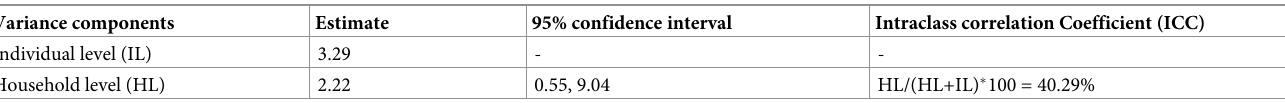
Table 3. Variance component analysis from the multilevel binary logistic regression model. Variance